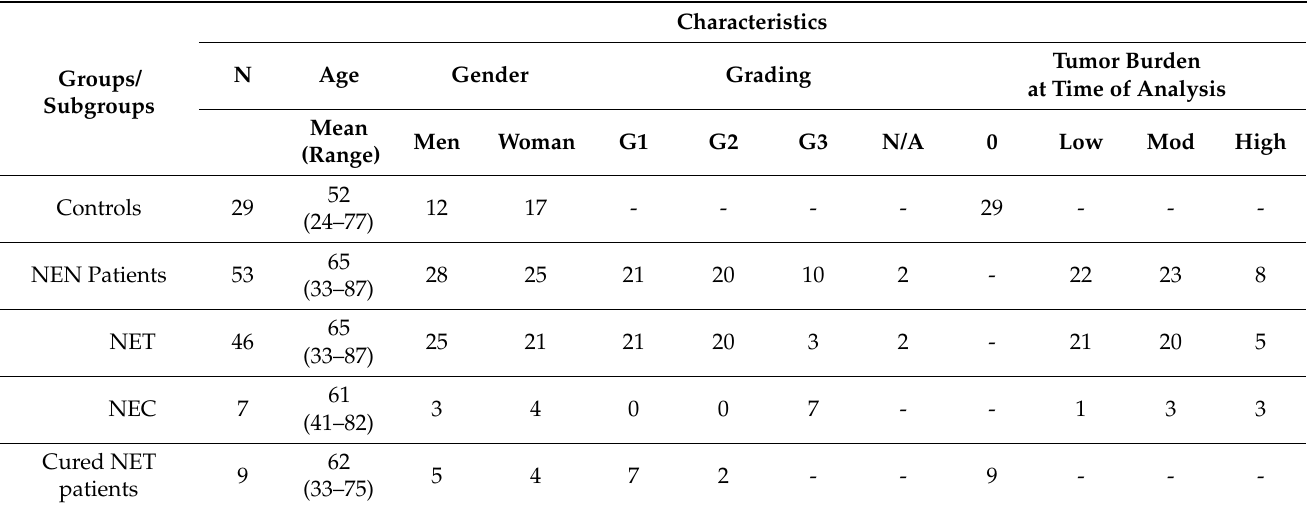
Table 1. Clinicopathological features of the study groups. Detailed baseline clinicopathological features of the study groups, including sex, age, tumor differentiation grade (G1: Grade 1,